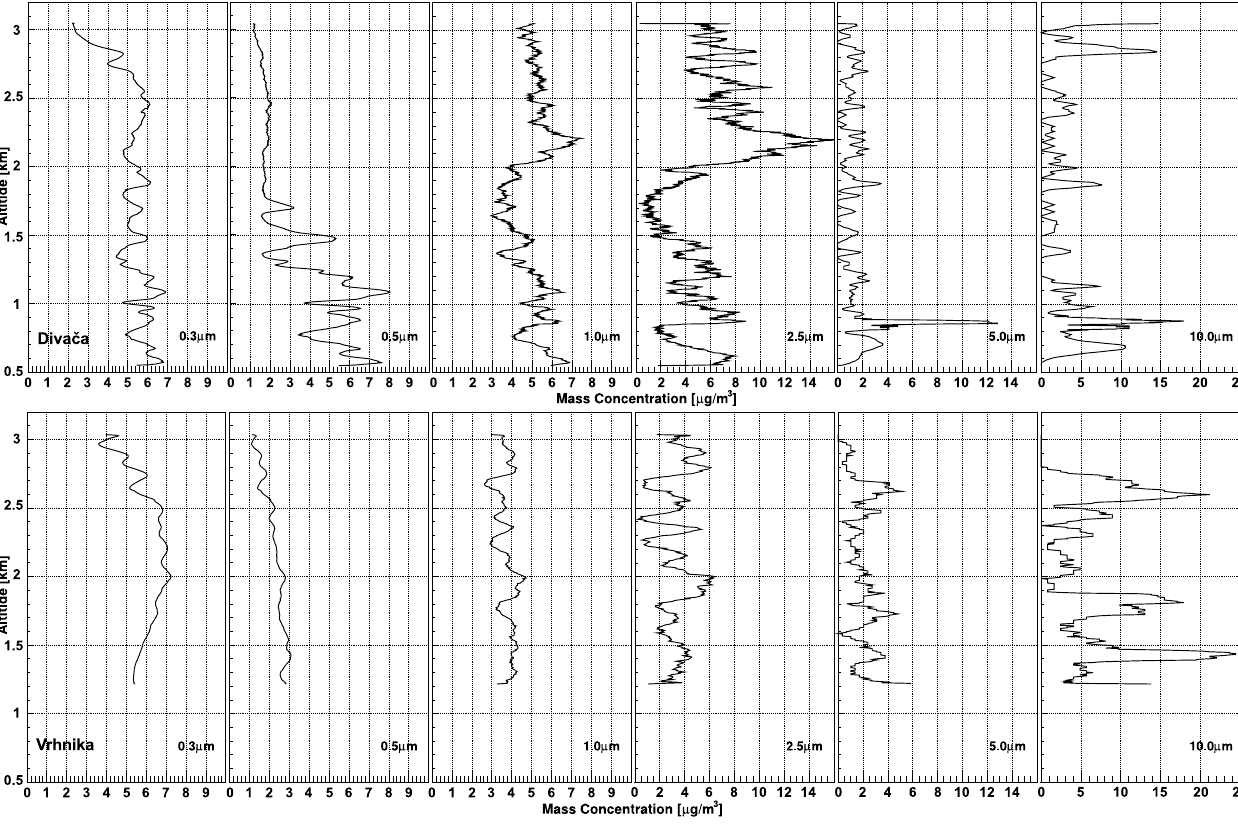
Fig. 8. Aerosol concentration profiles for six different aerosol dynamic equivalent diameters measured on 20 April 2010 above Divaˇca (top) and above Vrhnika